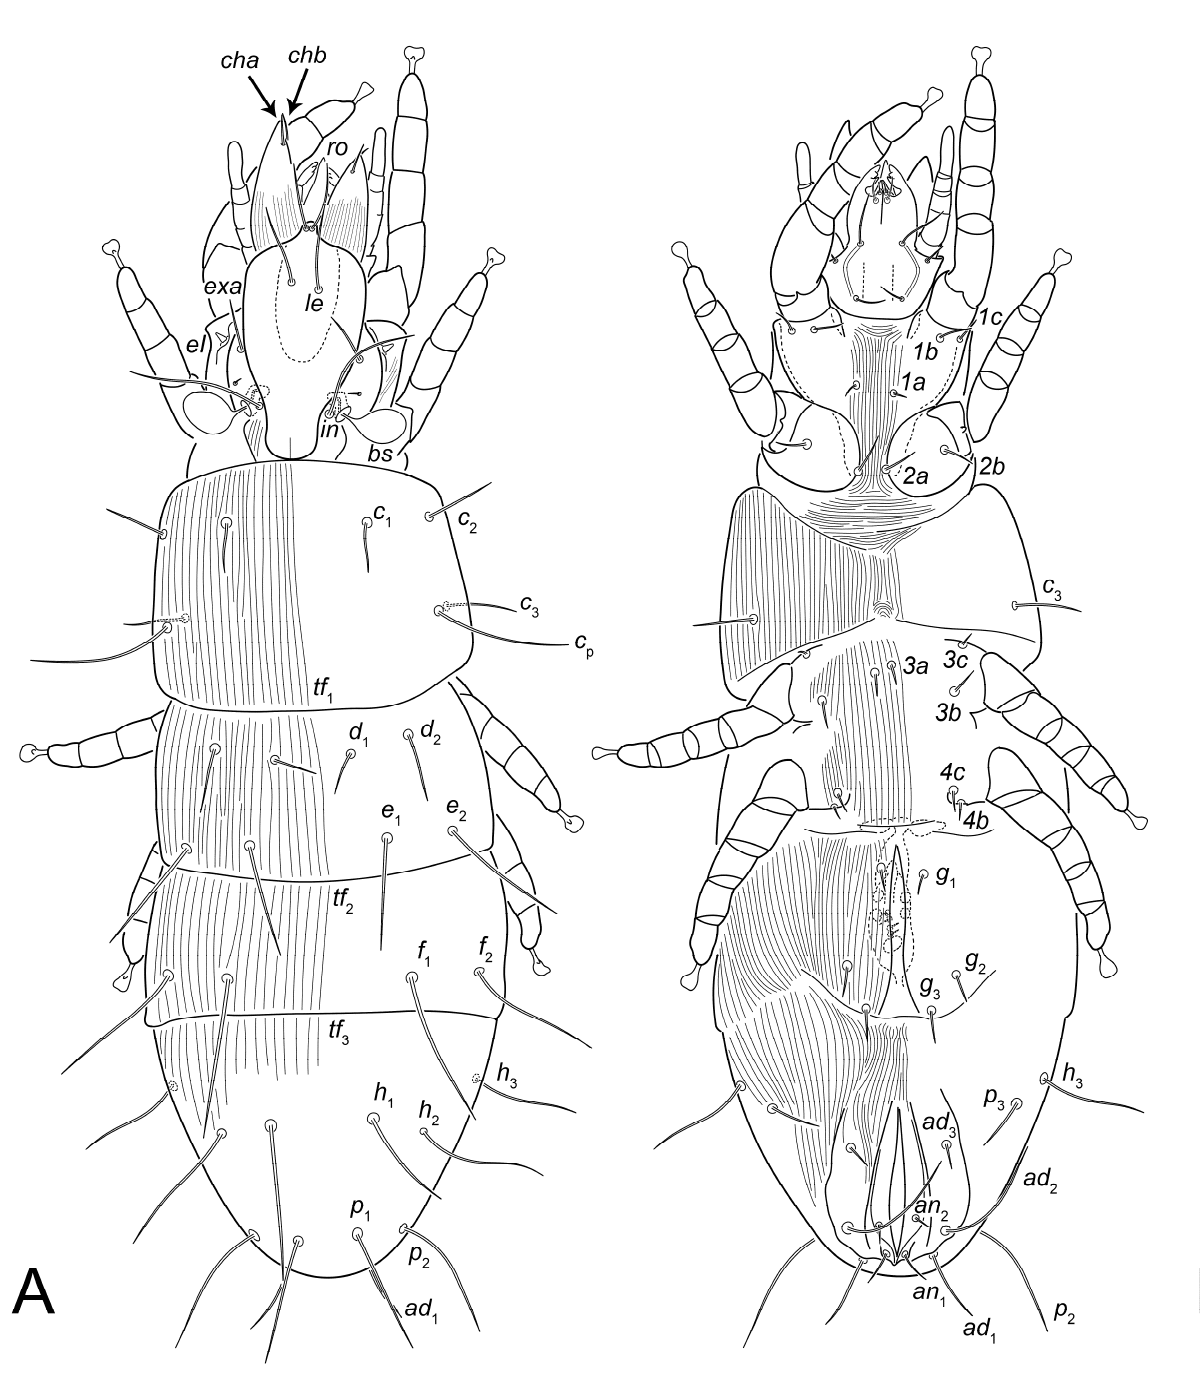
Figure 14. Paralycus persephone sp. n., female: ( A )—dorsal view; ( B )—ventral view. Scale bar 100 µm.